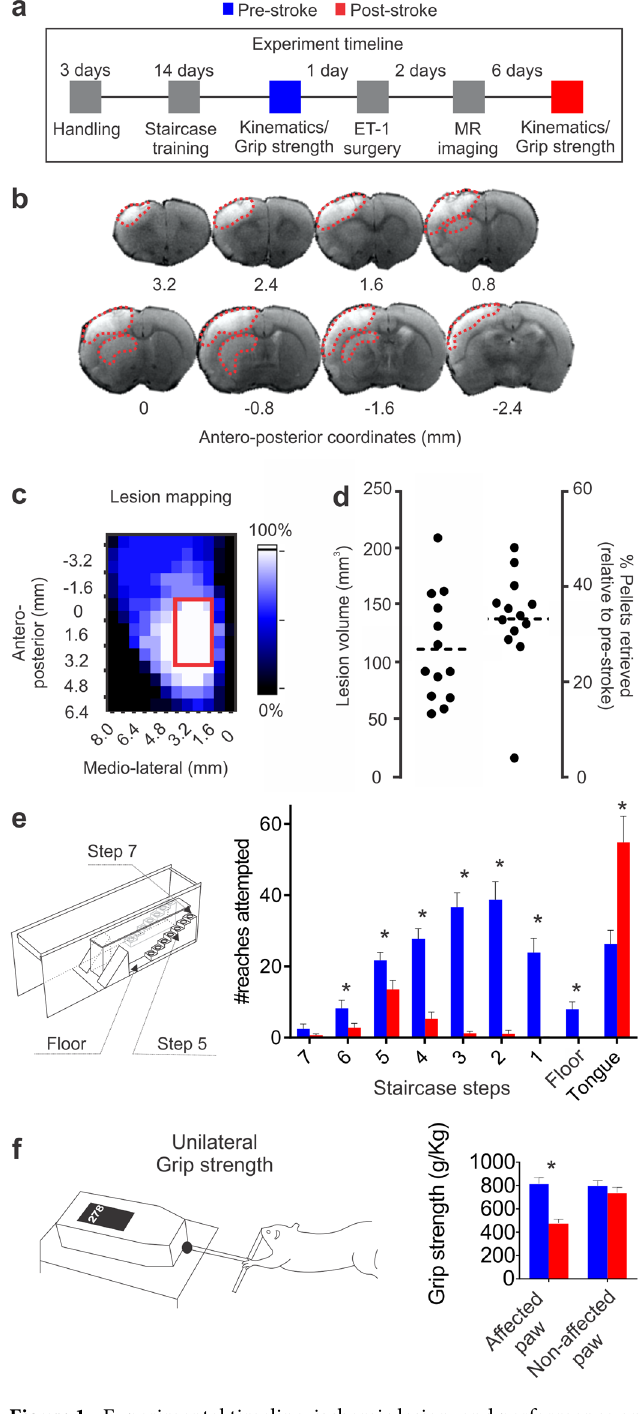
Figure 1. Experimental timeline, ischemic lesion, and performance on the staircase task. ( a ) Experimental timeline. ( b ) MRI images depict a representative ischemic lesion (~115.0 mm 3 ); the lighter coloured area in each coronal section is the ischemic region (red dashed lines). ( c ) Ischemic lesions were predominantly located in the caudal forelimb area in all animals (red rectangle) 36 . Voxel colour indicates proportion (0–100%) of animals with a lesion at a given location. (d, left panel) Lesion volume and (d, right panel) staircase impairment 8 days post-stroke. Each dot represents an individual animal, with the dotted line representing the mean of all animals. (e, left panel) Depicts staircase task and (e, right panel) number of reaches attempted to each staircase step. Following stroke animals made fewer reach attempts to most staircase steps. ( f ) Grip strength of the affected paw was reduced following stroke. * pre- versus post-stroke (p < 0.05). Paired t-test, n = 13 and mean ± s.e.m. for this and all subsequent